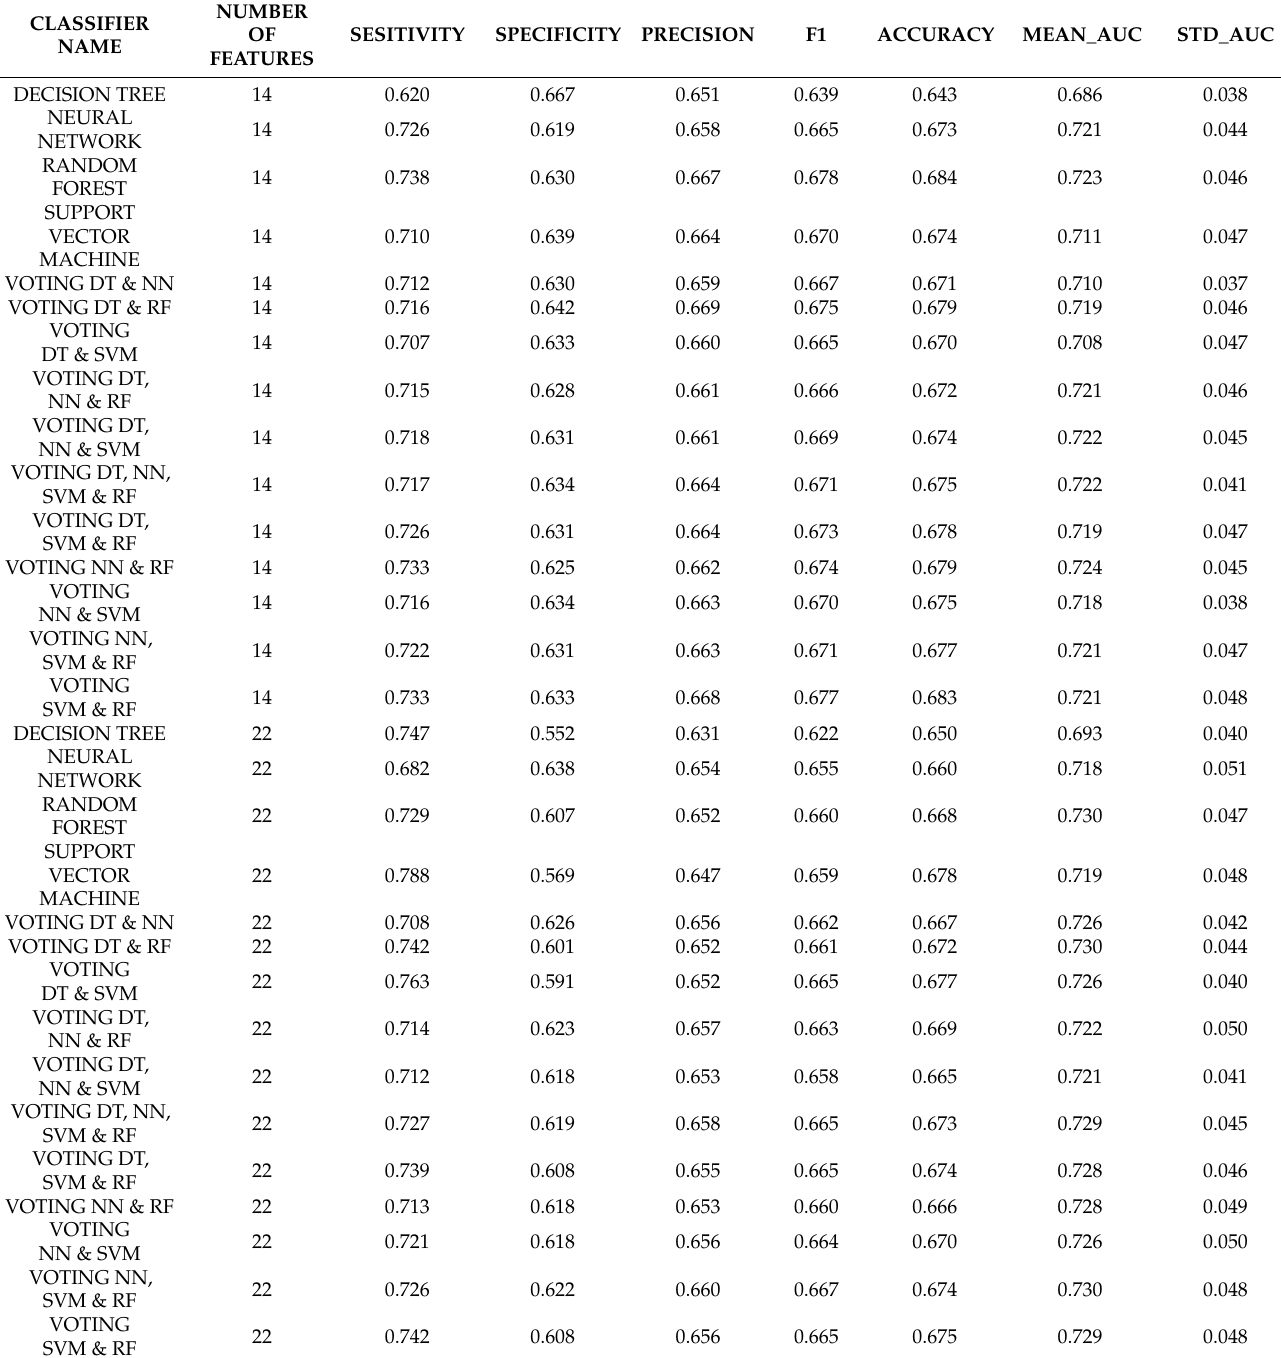
Table 3. Results after hyperparameter optimization for all classifiers with 14 and 22